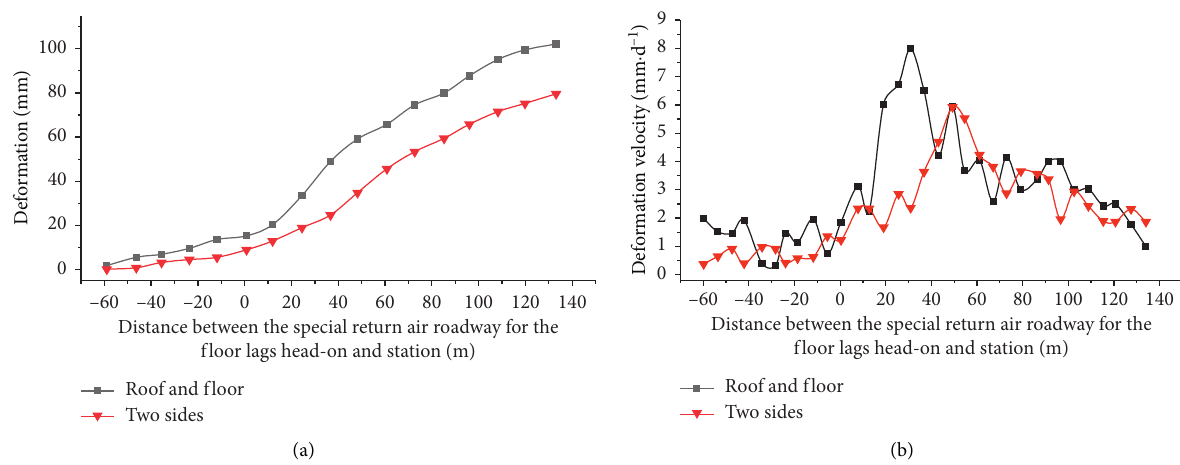
Figure 21: Deformation and deformation velocity of uphill conveyor belt roadway under the influence of special air-return roadway blast excavating: (a) deformation and (b) deformation